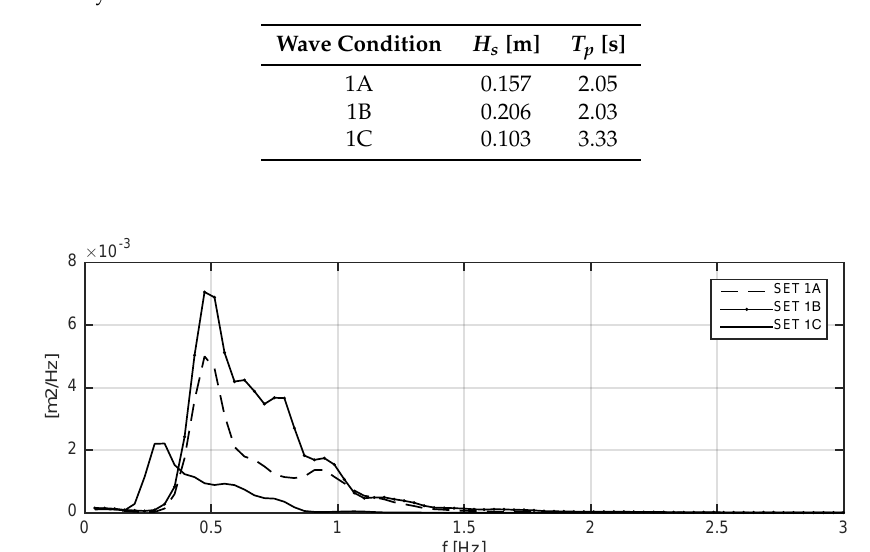
Table 3. Boers 1996 Wave conditions. All model configurations and results are pre-decisional and for official use only.